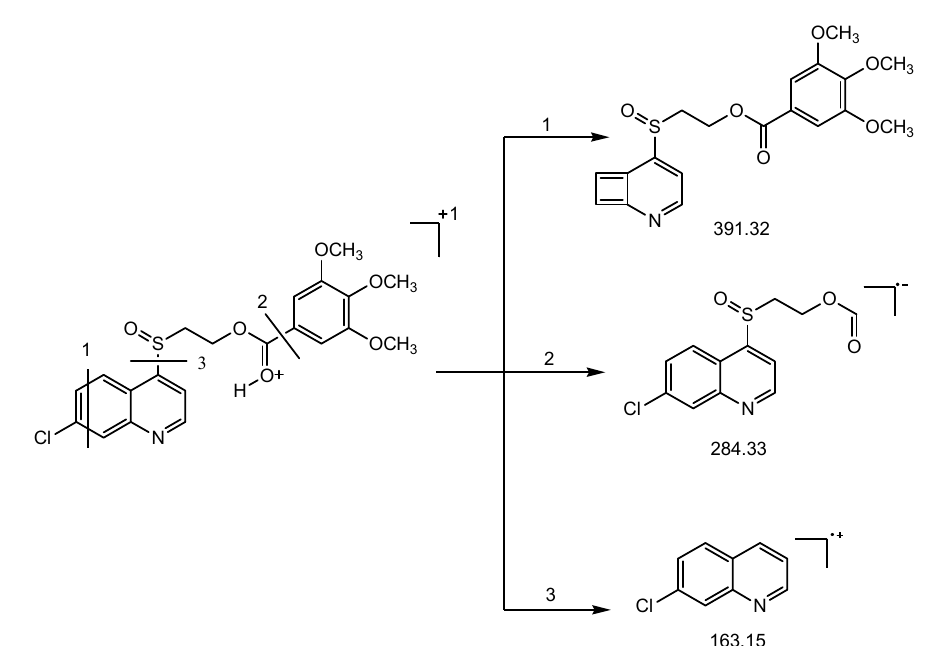
Figure 6. Mass spectrum of 46 and proposed fragmentation patterns.